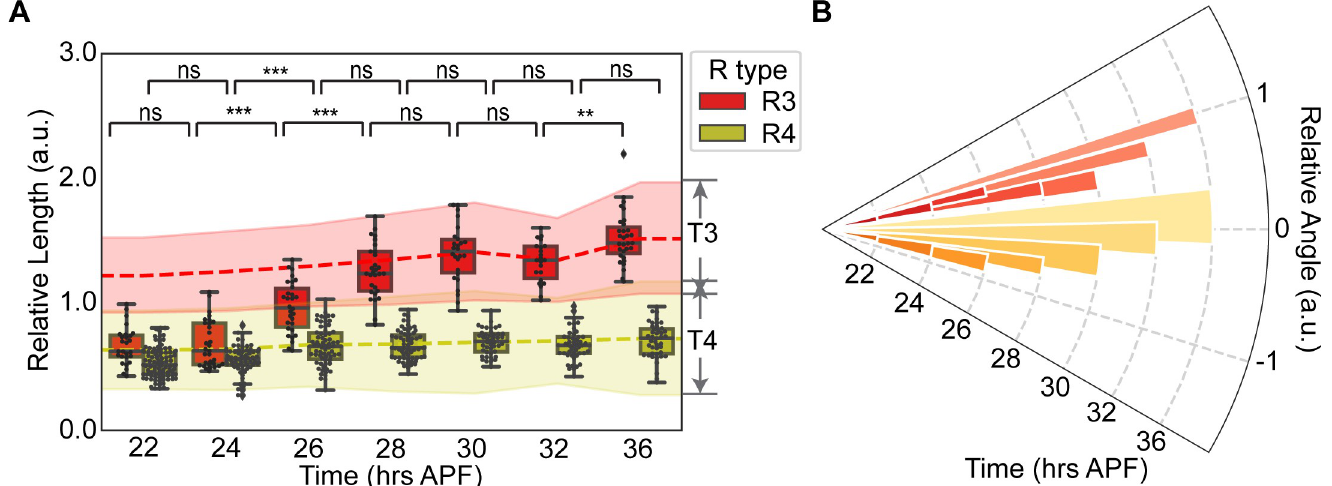
Fig 3. Wild-type R3s and R4s exhibit asymmetric speeds but symmetric directions of extension. (A) Changes in relative lengths of wild-type R3 and R4 growth cones over time. Red and yellow represent R3s and R4s, respectively. Dashed lines: mean of target centers. Error bars of the dashed lines: mean of the upper and lower boundaries of targets. Significance: calculated using a two-sided Mann-Whitney test with p values adjusted by Holm-Bonferroni method. ns: p � 0.05, � : 0.01 � p < 0.05, �� : 0.001 � p < 0.01, ��� : p < 0.001. Sample sizes (number of bundles) of each time point: R3 growth cones (n = 27, 31, 30, 29, 26, 22, 31); R4 growth cones (n = 93, 67, 67, 66, 44, 46, 43). n � 2 biological replicates for each time point. (B) Changes in relative angles of wild-type R3 and R4 growth cones over time. Red and yellow bars represent R3s and R4s, respectively. Radial coordinate indicates time, angular coordinate indicates mean relative angle of R3 or R4 growth cones at the given time point, and width of bars indicates standard deviation of angle values at the given time point. Sample sizes as in (A). See S2 Fig for representative images of each time point. See S1 Table for p-values and S1 Data for data used to generate this figure.